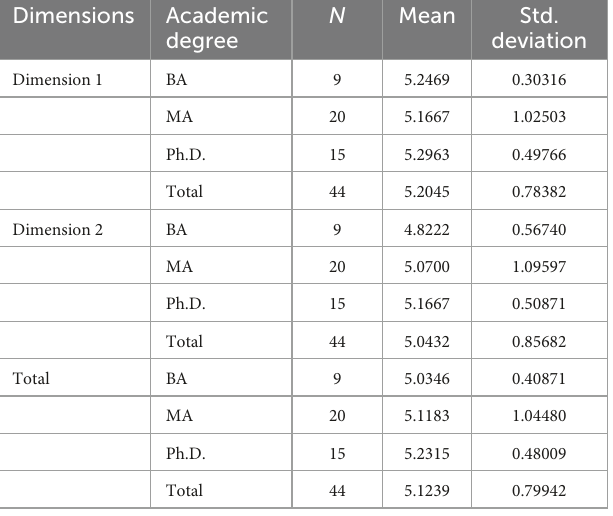
TABLE 9 Results of one-way ANOVA (based on academic degree). Dimensions